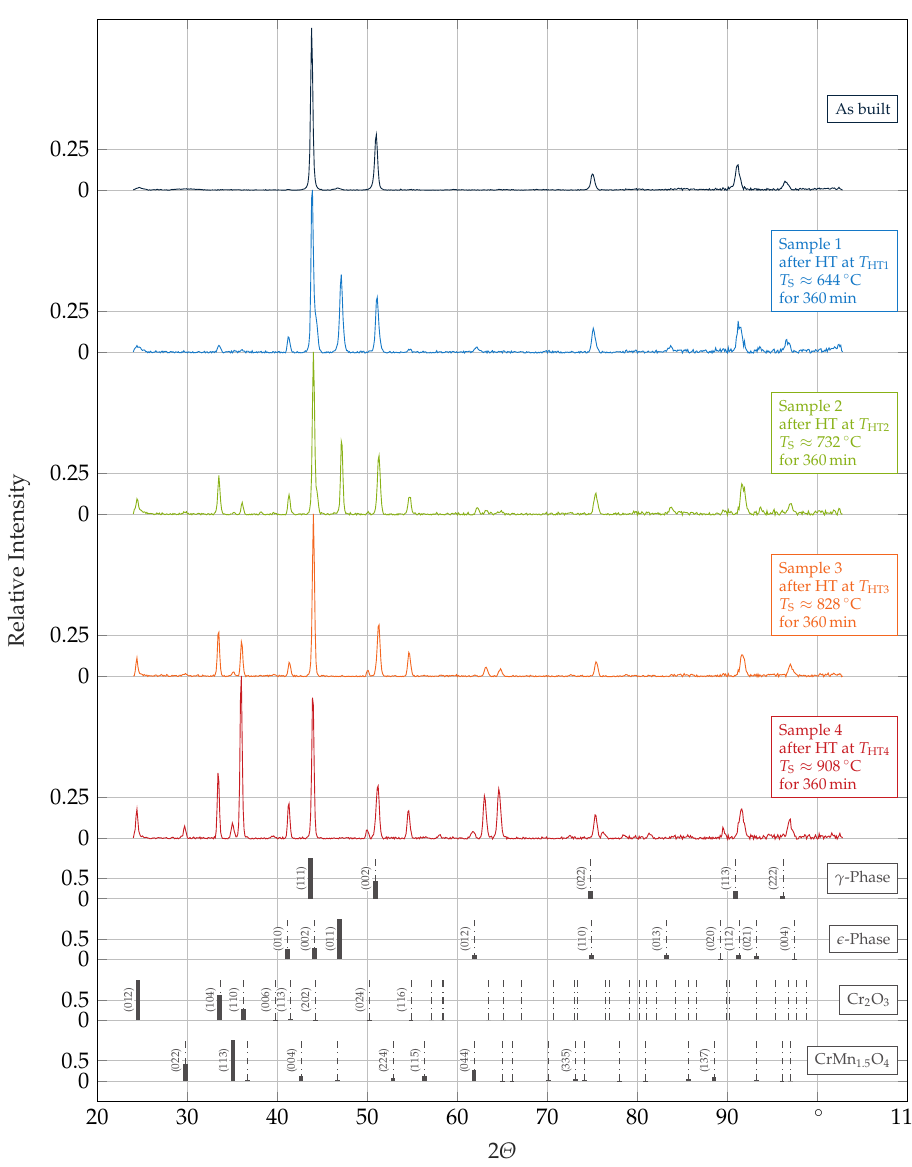
Figure 5. In color: Ex-situ XRD diffractograms, with intensities normalized to the highest peak in the respective pattern, of samples composed of a Co-Cr-W alloy in states AB by L-PBF and after HTs measured on the samples’ surface. Additionally in grey: Stick reference pattern calculated with VESTA [32] of a solution of W in Co fcc γ -phase (COD:1524796 [33]), a solution of W in Co hcp (cid:101)